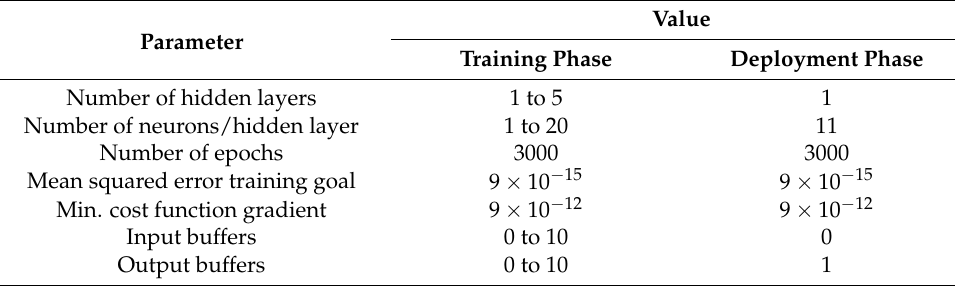
Figure 5. Considered NARX RNN architecture with two inputs. Table 3. NARX RNN—layout 1: parameters used for training and deployment. Table 3. NARX RNN—layout 1: parameters used for training and